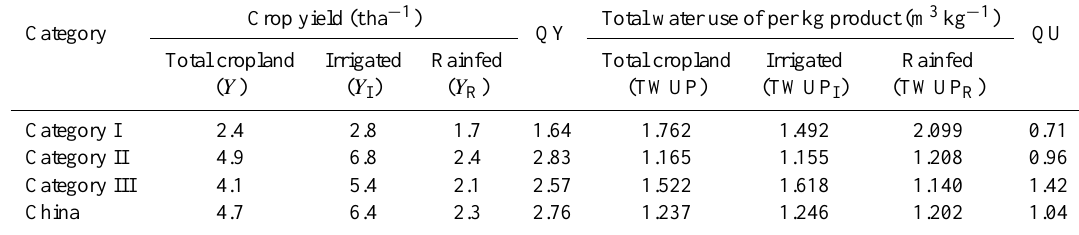
Table 4. Crop yield and total water use of per kg wheat product for three categories. Crop yield (tha − 1 ) Category Total cropland